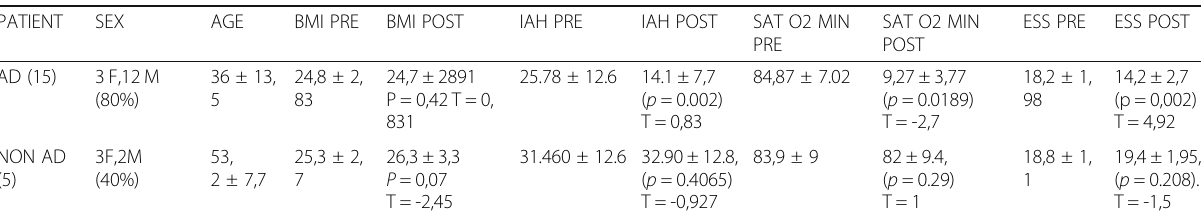
Table 2 Main grouped results PATIENT